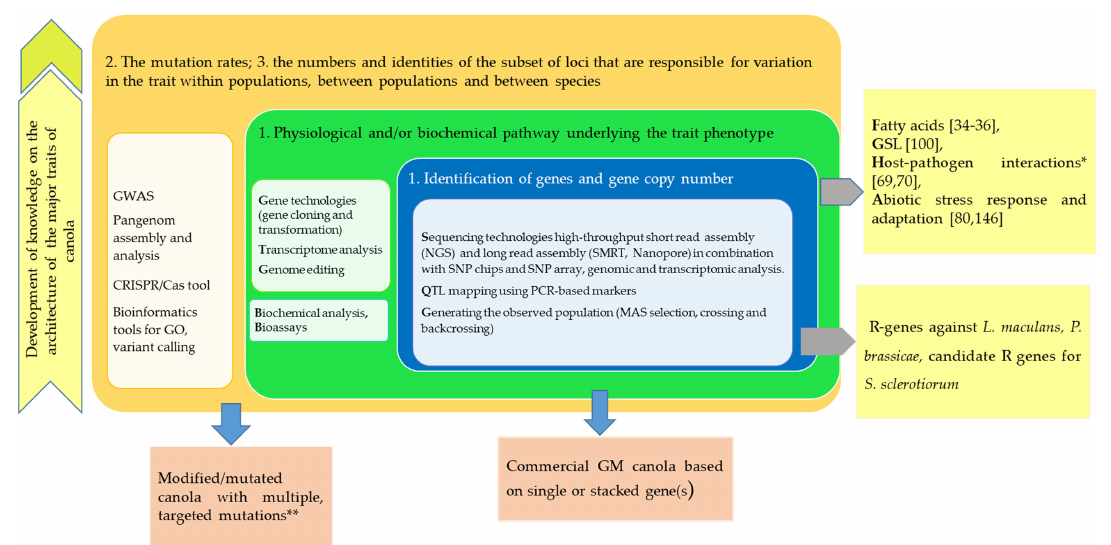
Figure 2. Contributions of the modern genetic and gene technologies to the understanding of the genetic architecture of the major traits of Brassica oilseed crop, adapted from Mackay [179] suggestions, and achievements in canola variety research and development. GWAS, Genome-Wide Association Study; CRISPR/Cas, the clustered regularly interspaced short palindromic repeat; GO, gene ontology; NGS, next-generation sequencing technique; SMRT, single molecule real time; SNP, single nucleotide polymorphism; QTL, quantitative trait loci; MAS, marker-assisted selection; GSL, glucosinolate; GM, genetically modified; (*) molecular biology fundamentals of these mechanisms is being established; (**) products from experimental studies.